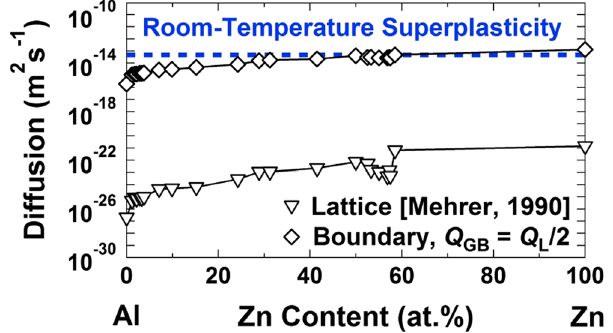
Figure 4. Diffusion coefficient for the room-temperature superplasticity after SPD processing is comparable to the reported data for grain-boundary diffusion in Zn. Lattice and grain-boundary diffusion in the Al-Zn system reported in ref. 12 in comparison with the diffusion coefficient calculated using equation (1) using the parameters described in the main text for room-temperature superplasticity in this